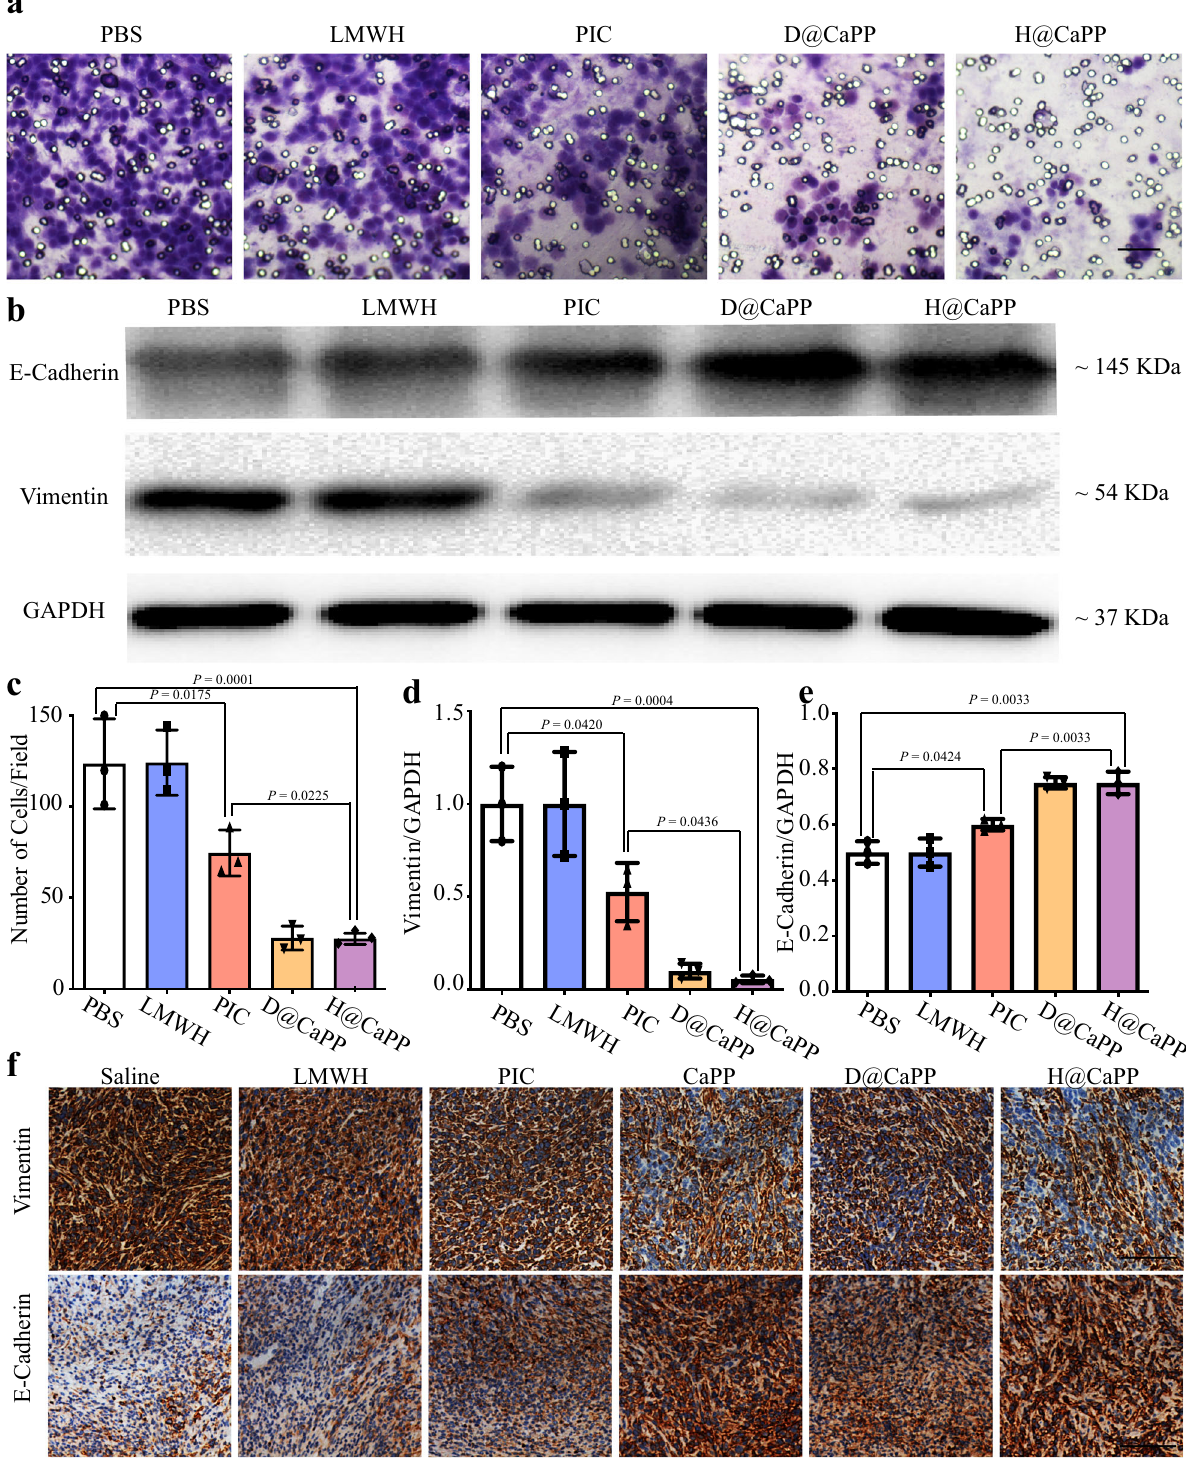
Fig. 5 H@CaPP hindered invasion of the primary tumor by inhibiting the EMT process. a Images and c quantitative analyses of the number of invaded 4T1 cells after incubating tumor cells with PBS, LMWH, piceatannol, D@CaPP, or H@CaPP (dose of free piceatannol or PP at 10 μ M, dose of Dextran or LMWH at 1.3 mg/mL) for 24 h. The cells were stained with crystal violet and each purple spot represented one invaded cell at the fi eld of vision (ANOVA, means ± SD, n = 5 fi elds per group). b Representative image of Western blot analysis of Vimentin and E-cadherin in 4T1 cells. d Quantitative analysis of the expression of Vimentin and e E-cadherin in 4T1 cells (ANOVA, means ± SD, n = 3 samples per group). f Representative images of immunological analysis of Vimentin and E-cadherin (brown) in tumors after intravenously administrated with saline, LMWH, piceatannol, CaPP, D@CaPP, and H@CaPP (i.v. at a dose of piceatannol or PP at 0.020 mmol/kg, at a dose of Dextran or LMWH at 10 mg/kg) for seven times in 14 days. Scale bar, 50 μ m. One-way ANOVA with Tukey ’ s multiple comparisons test (one-sided) was used for c – e . Error bars represent